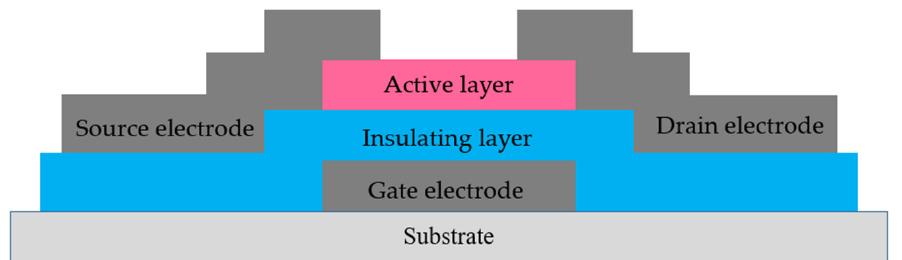
Figure 1. Schematic diagram of TFT device structure.